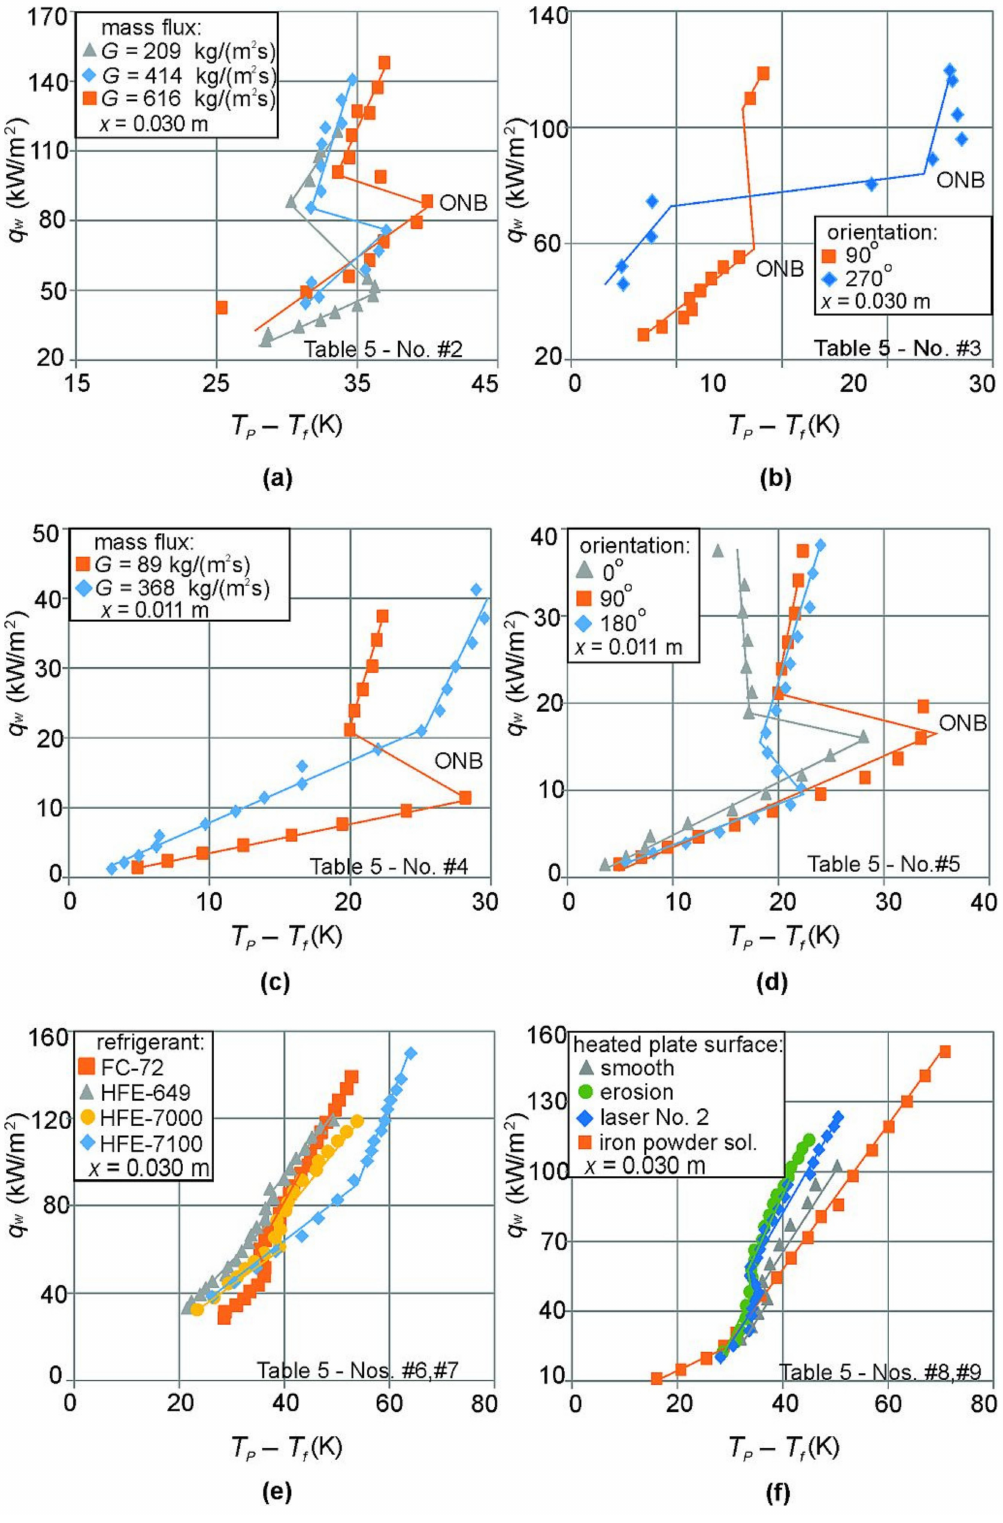
Figure 16. Boiling curves generated for two distances from the mini-channel inlet: ( a , c , d ) 0.030 m ( L IRT = 180 mm), ( b ) 0.011 m ( L IRT = 32 mm). Experimental parameters are shown in Table 5, Nos. #2 to #9. ONB - onset of nucleate